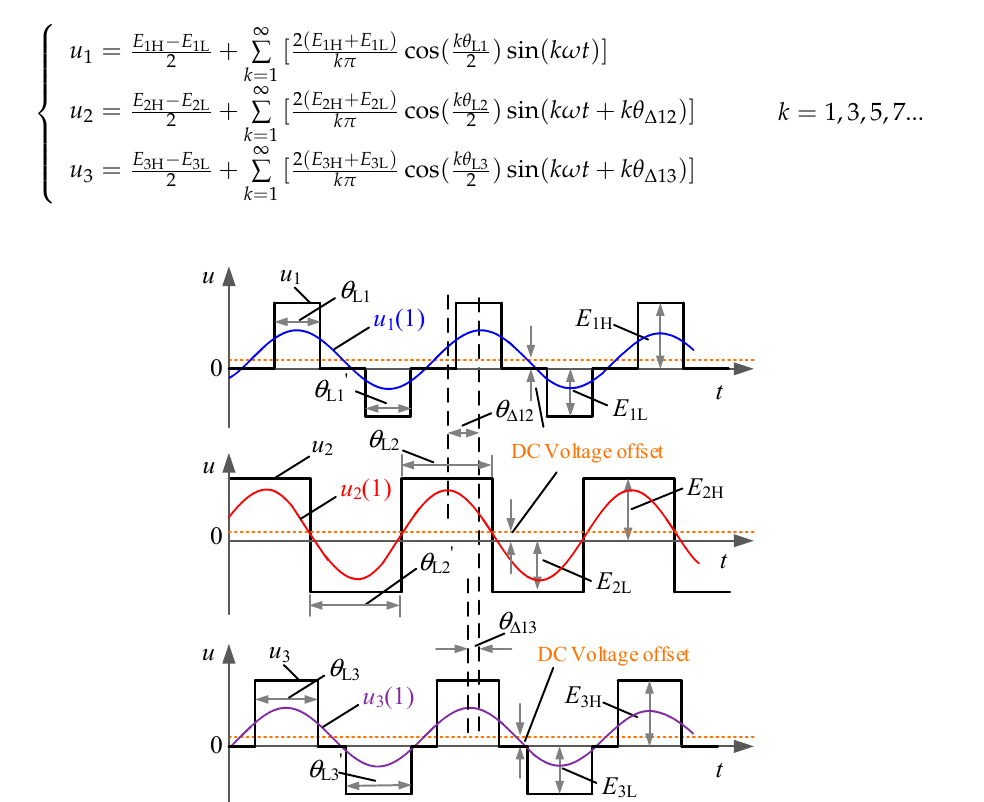
Figure 3. The output voltage waveforms of parallel two inverters.